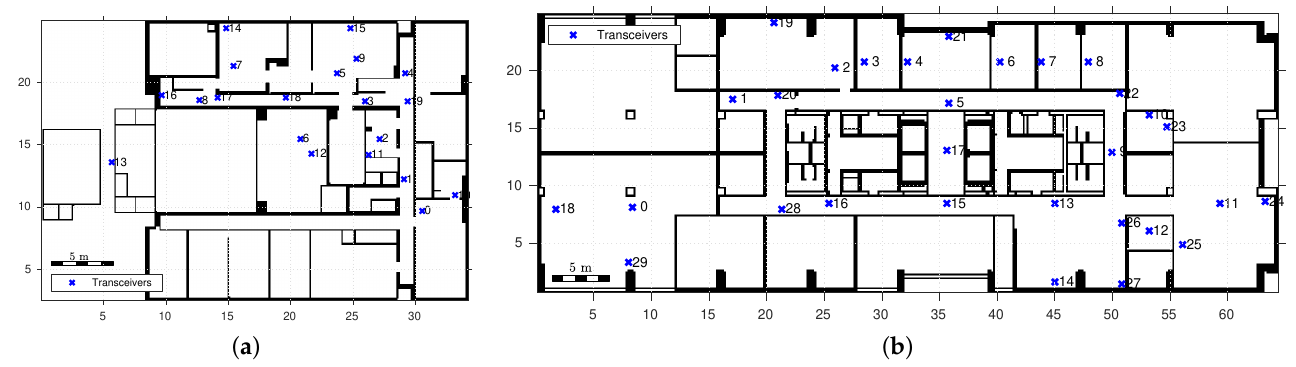
Figure 2. Floor map of the measurement environments and wireless sensor network deployment. The ship environment is show in ( a ) and the office environment in ( b